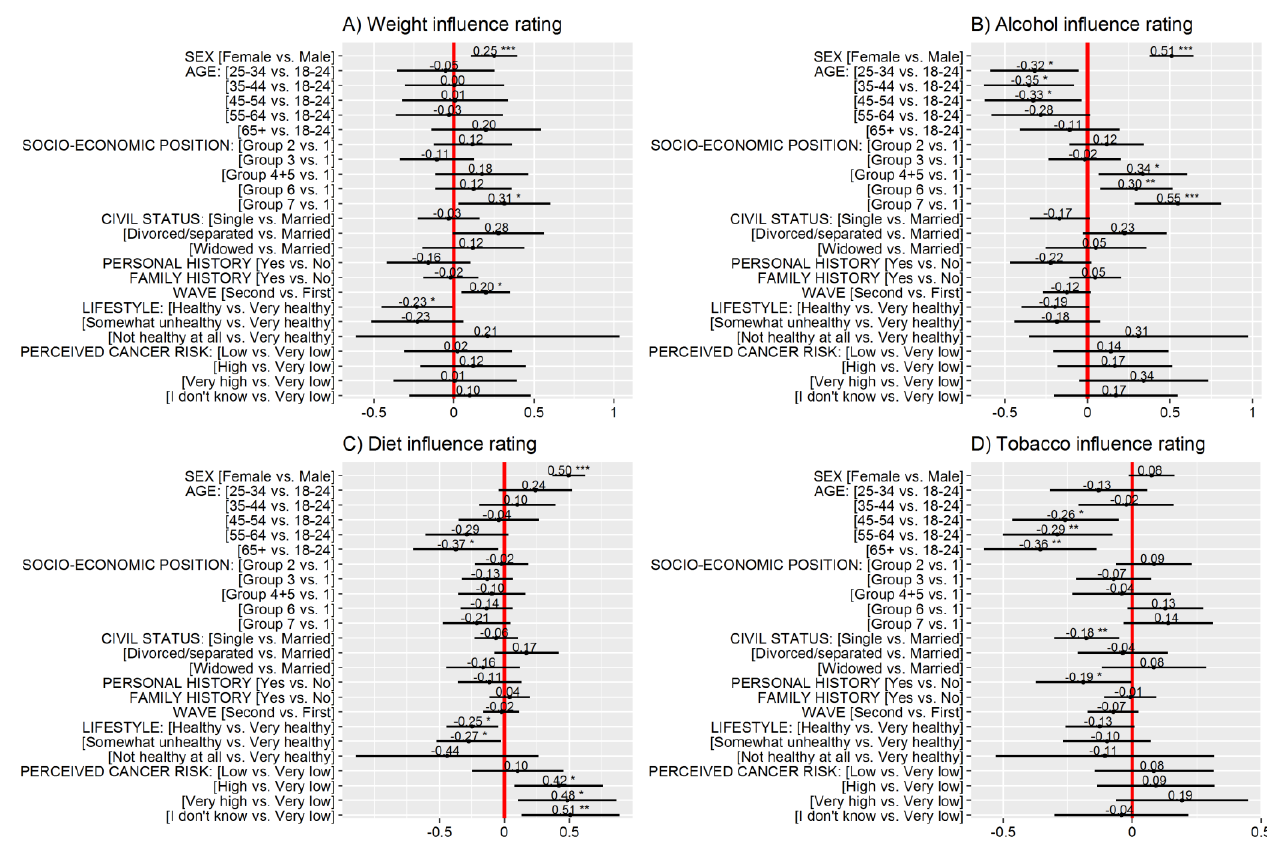
Figure A1. Linear regression coefficients (black dots) and 95% confidence intervals (CI) derived from multiple regression models with outcomes influence ratings from 1 to 10 of ( A ) weight, ( B ) alcohol, ( C ) diet, and ( D ) tobacco on the development of cancer. Note: * p < 0.05, ** p < 0.01, *** p < 0.001. If the coefficient and its CIs are to the left of the red reference line, the indicated group gave on average a lower influence rating than the reference group. If the coefficient and its CIs are to the right of the red reference line, the indicated group gave on average a higher influence rating than the reference group. For civil status, the category “Married” includes married and cohabiting.